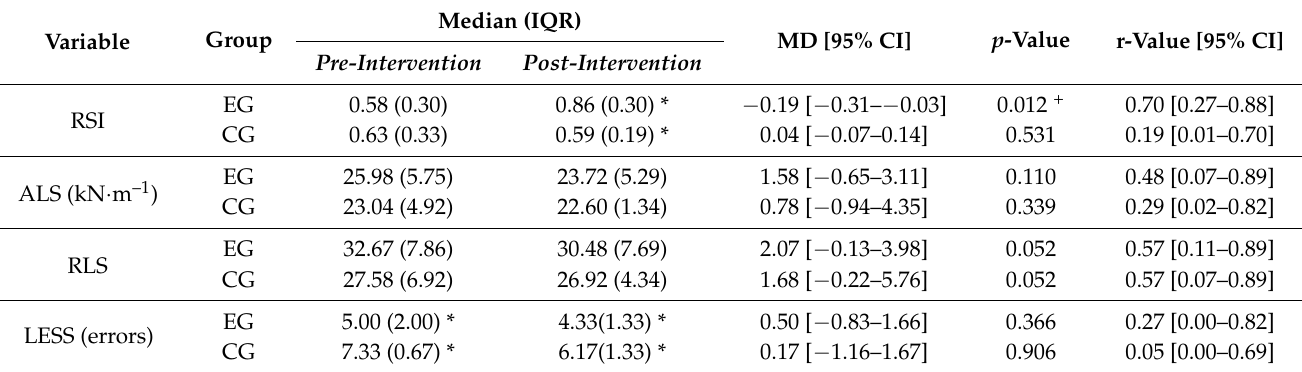
EG—experimental group, CG—control group, SD—standard deviation, CI—confidence intervals, IQR— interquartile ranges, MD—Hodges–Lehmann estimate of the median differences. * Significant difference